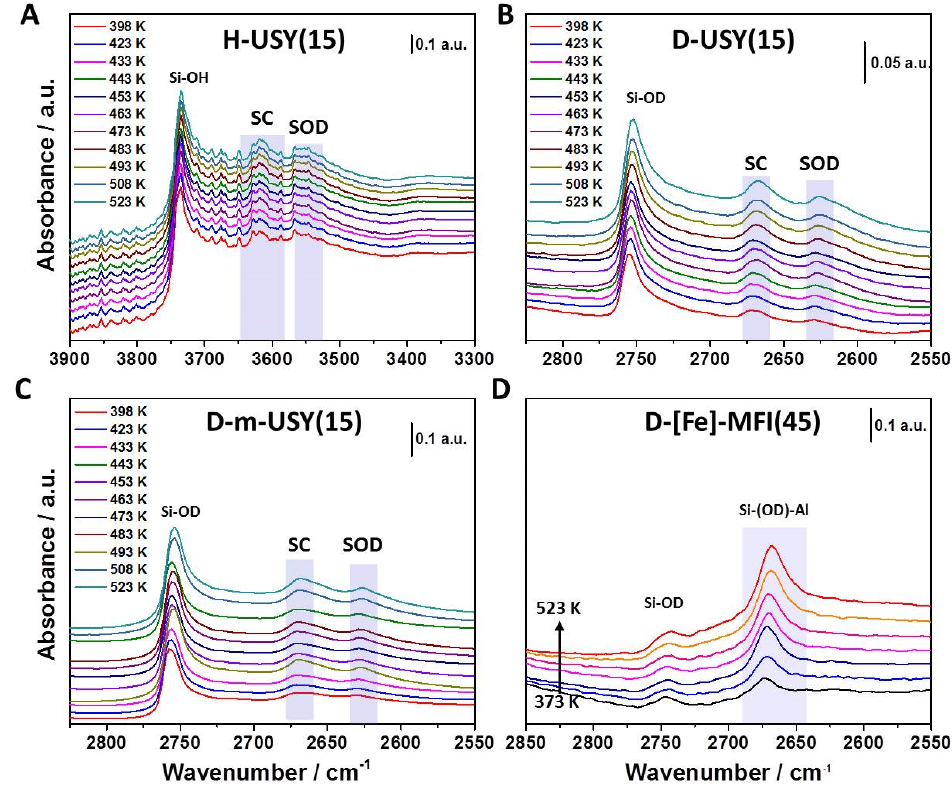
Figure 1. Varying temperature infrared spectroscopic (VTIR) spectra for H / D exchange for ( A ) O-H stretching region of H-USY(15), ( B ) O-D stretching region for D-USY(15), ( C ) D-m-USY(15), and ( D ) D-[Fe]-ZSM-5(45). To determine peak positions and to integrate relative signal intensities, a second derivative baseline was used. Absolute integrated areas were used in the following data treatment.